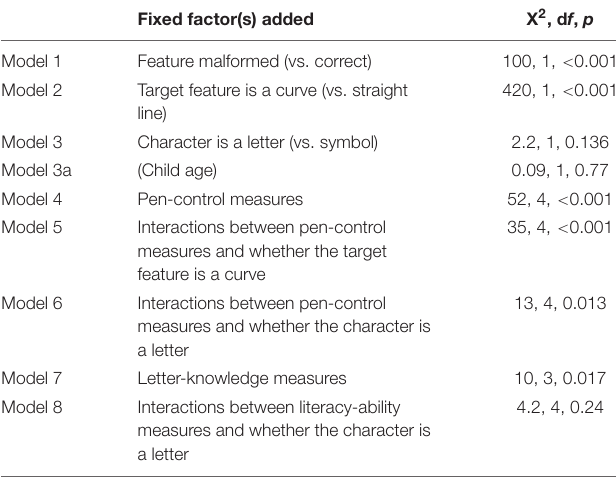
TABLE 2 | Model comparison for models predicting pen-movement disfluency (velocity peak count) in the character copying task.